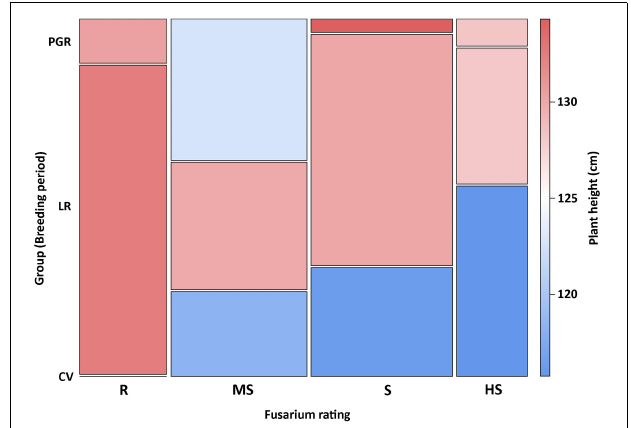
FIGURE 2 | Frequency of genotypes admitted to breeding group (CV, modern varieties; LR, landrace/old varieties; PGR, plant genetic resources) and Fusarium rating (R, resistant; MS, moderately susceptible; S, susceptible; HS, highly susceptible). The association between color intensity and plant height is indicated by the color